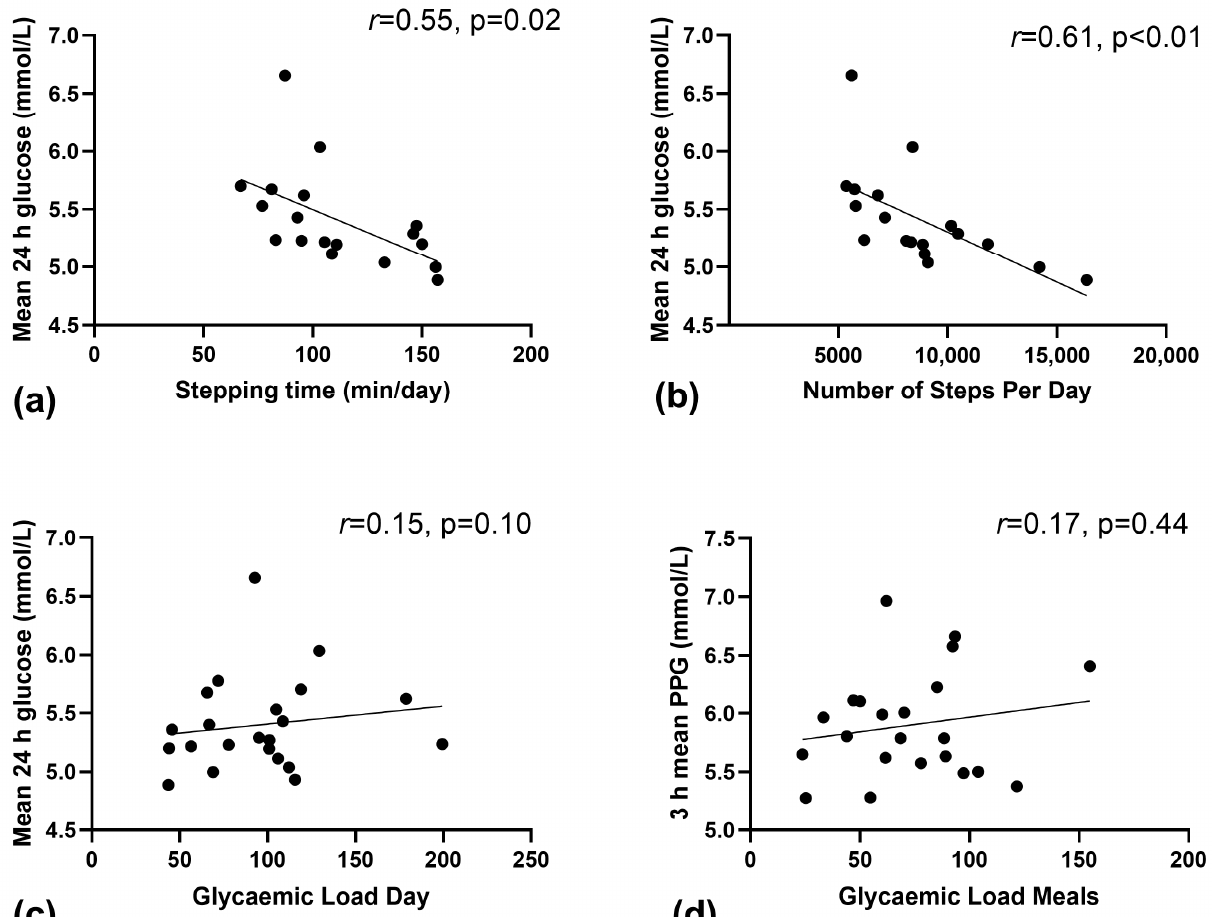
Figure 1. Relationship between continuous glucose derived measures of glucose and physical activity and glycaemic load (GL) in free-living women with GDM. ( a ) Mean 24 h glucose and stepping time, ( b ) Mean 24 h glucose and the number of steps/day, ( c ) Mean 24 h glucose and daily glycaemic load, and ( d ) mean 3 ‐ h postprandial blood glucose and glycaemic load of main meals.